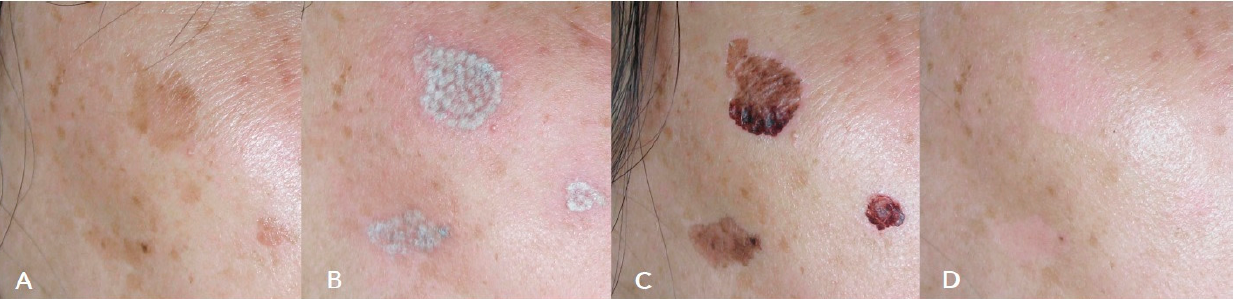
Figure 5. Patient 16’s right side before ( A ), right after ( B ), 1 week after ( C ) and 8 weeks after treatment with Nd:YAG laser ( D ).